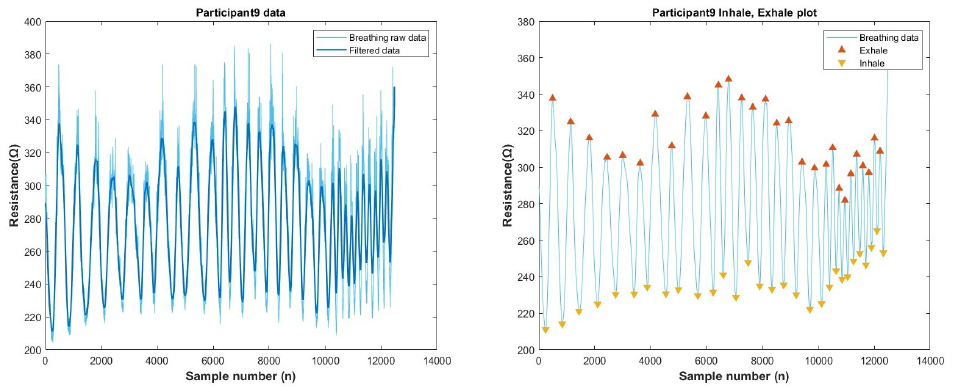
Figure 17. Respiration data analysis (Participant-9). Left-raw and filtered data, right-peak detection for inhale and